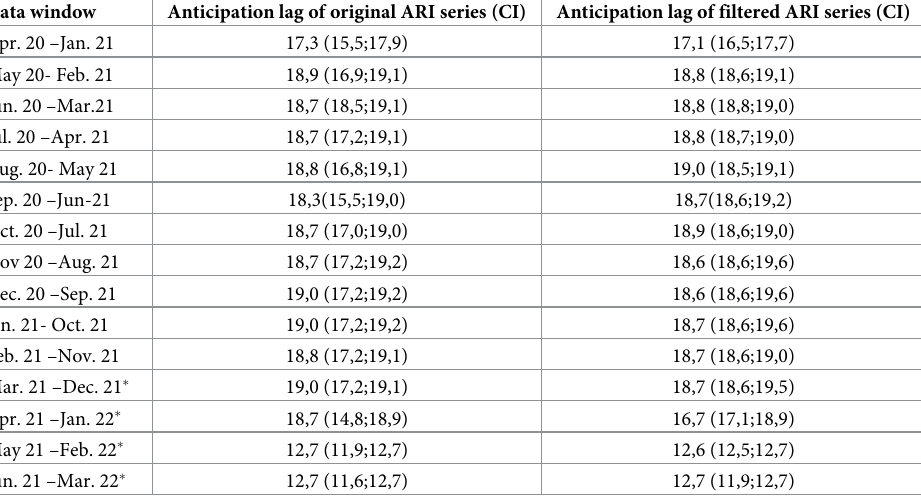
Table 2. Anticipation lag (in days) of Acute Respiratory Infection (ARI) cases with Codid-19 diagnosed in Pri- mary Care (original and filtered) for Intensive Care Unit (ICU) Bed Occupancy of Covid-19 patients, in a rolling window from April 2020 to March 2022 in Catalonia, Spain (with confidence intervals,